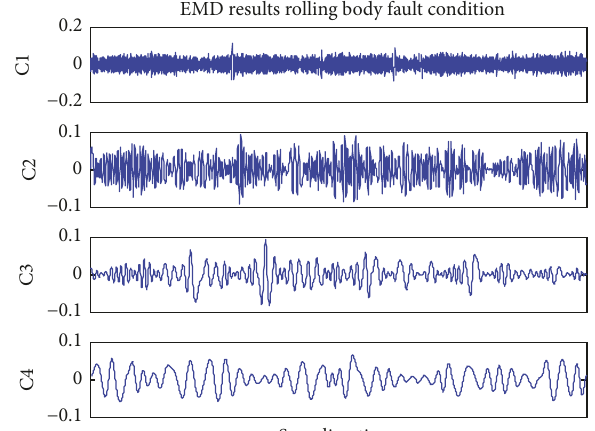
Figure 9: The results of EMD for normal